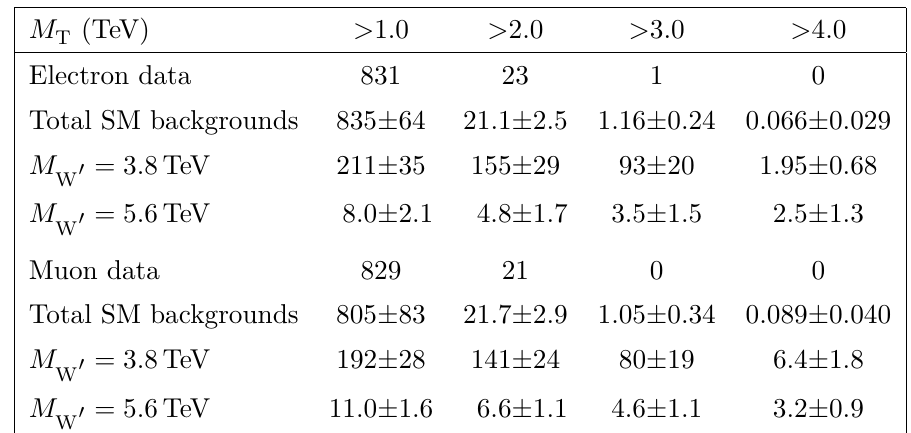
Table 1 . The observed and expected number of events in the electron (upper) and muon (lower) channels, collected during three years (2016–2018), for selected values of M threshold. Predicted T numbers of SSM W 0 events are given, for M = 3 . 8 and 5.6 TeV. The statistical and systematic W 0 uncertainties are added in quadrature to provide the total